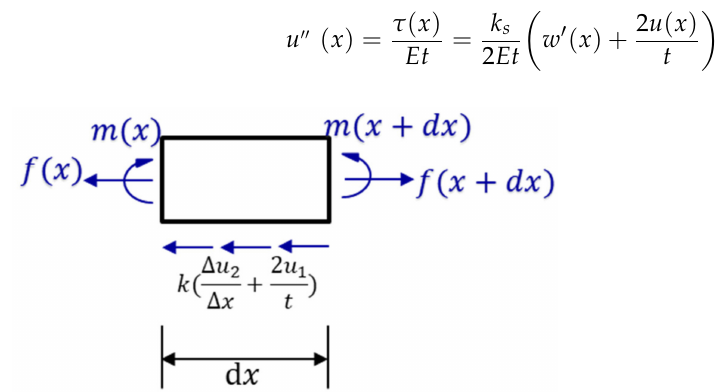
Figure A3. A free body diagram of a small segment of the upper